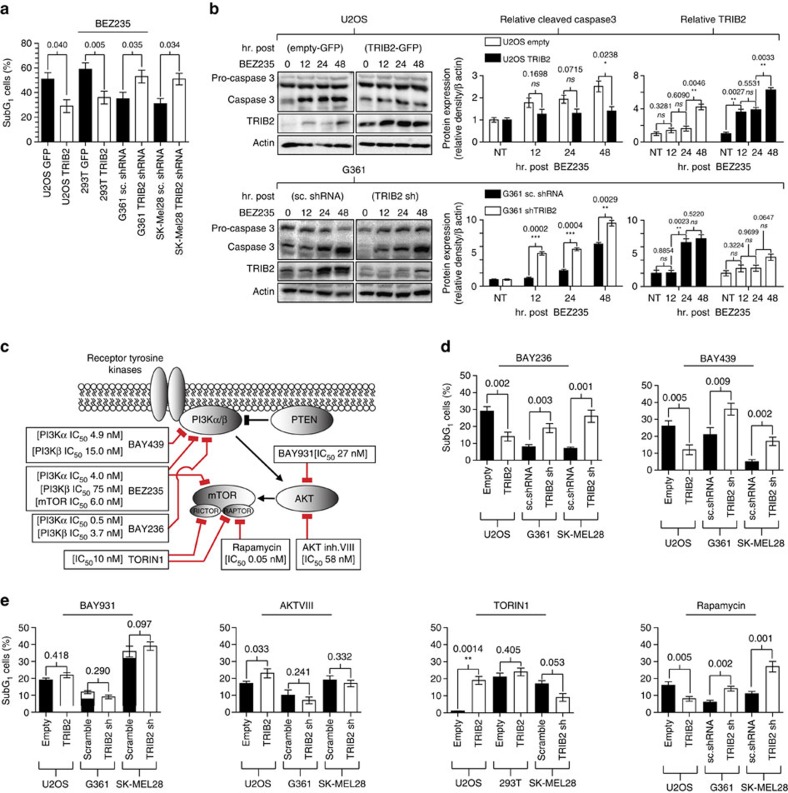
Overexpression of TRIB2 confers in vitro resistance to PI3K inhibitors.(a) Matched isogenic TRIB2 cell line FACS analysis following exposure to BEZ235 (n=6), sc.shRNA indicates scramble shRNA while TRIB2 shRNA indicates stable shRNA knockdown for TRIB2 in each cell lines. P values are indicated for each comparison by two-way analysis of variance (ANOVA) and data represent the mean±s.d. (b) (left) Higher pro-caspase3 and reduced cleavage of caspase3 in TRIB2 overexpressing cells after treatment with BEZ235, (50 μg total protein loaded per lane and separated by 10% SDS–PAGE). (right) Densitometry for cleaved caspase3 and TRIB2 under each condition. Data normalized to actin and analysed in ImageJ. Data indicates relative mean intensity±s.e.m and analysed by two-way ANOVA. (c) Schematic showing the target specificity for each compound, the inhibitory concentration 50% (IC50) and commercial name. (d) FACS analysis of TRIB2 isogenic cell lines 72 h post exposure to various pre-clinical PI3K inhibitors (n=6). (e) Isogenic TRIB2 cell line FACS analysis 72 h post-AKT, mTOR1/2 or mTOR1 inhibition (n=6). P values are indicated for each comparison by two-way analysis of variance (ANOVA) and data represent the mean±s.d.